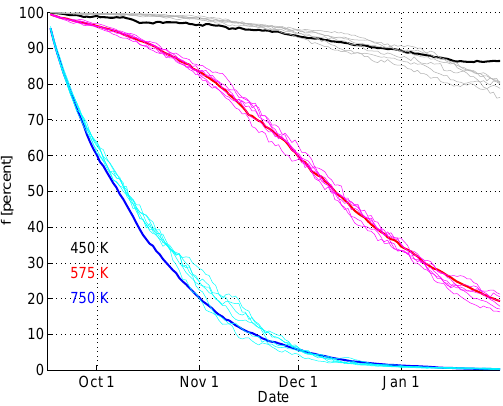
Fig. 3. Temporal evolution of the surviving fraction of an artifi- cial ozone perturbation on 16 September 1999 at 450K (thick black line), 575K (thick red) and 750K (thick blue), averaged over equiv- alent latitudes greater than 65°N. Note that the lines do not show the same air mass at different dates. Air masses shown at later dates will have experienced more subsidence. Thin lines show results for additional runs at reduced resolution for the years 2005/2006 to 2010/2011.